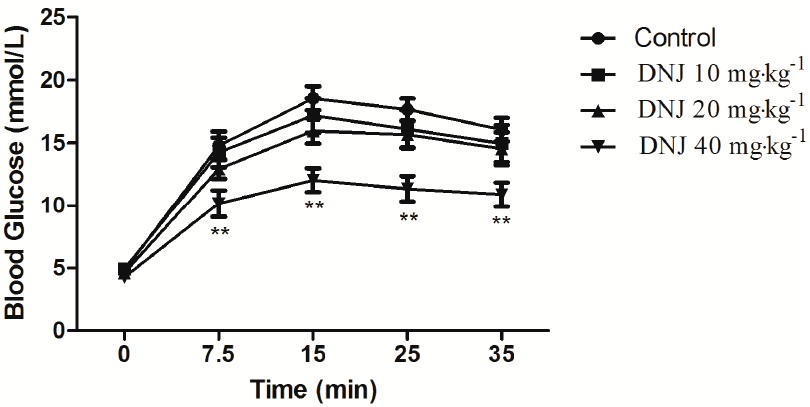
Figure A2. Effect of DNJ (10, 20, and 40 mg·kg − 1 ) on glucose tolerance test of ICR mice. ** p < 0.01 vs. control ( n = 10).